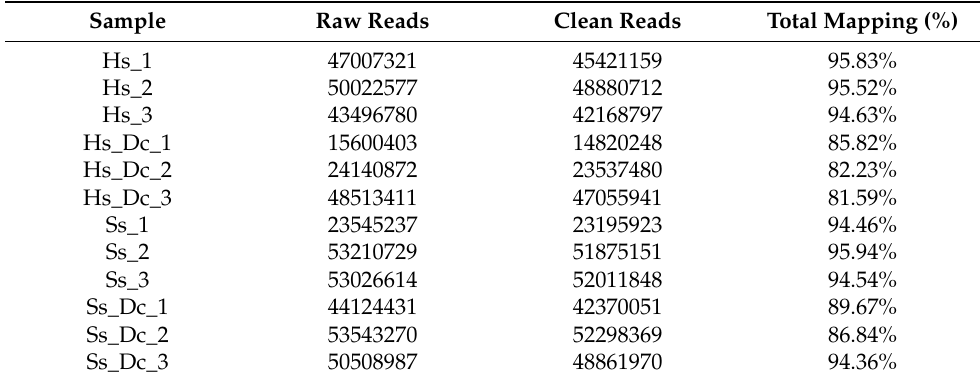
Table 1. RNA sequencing and genome mapping